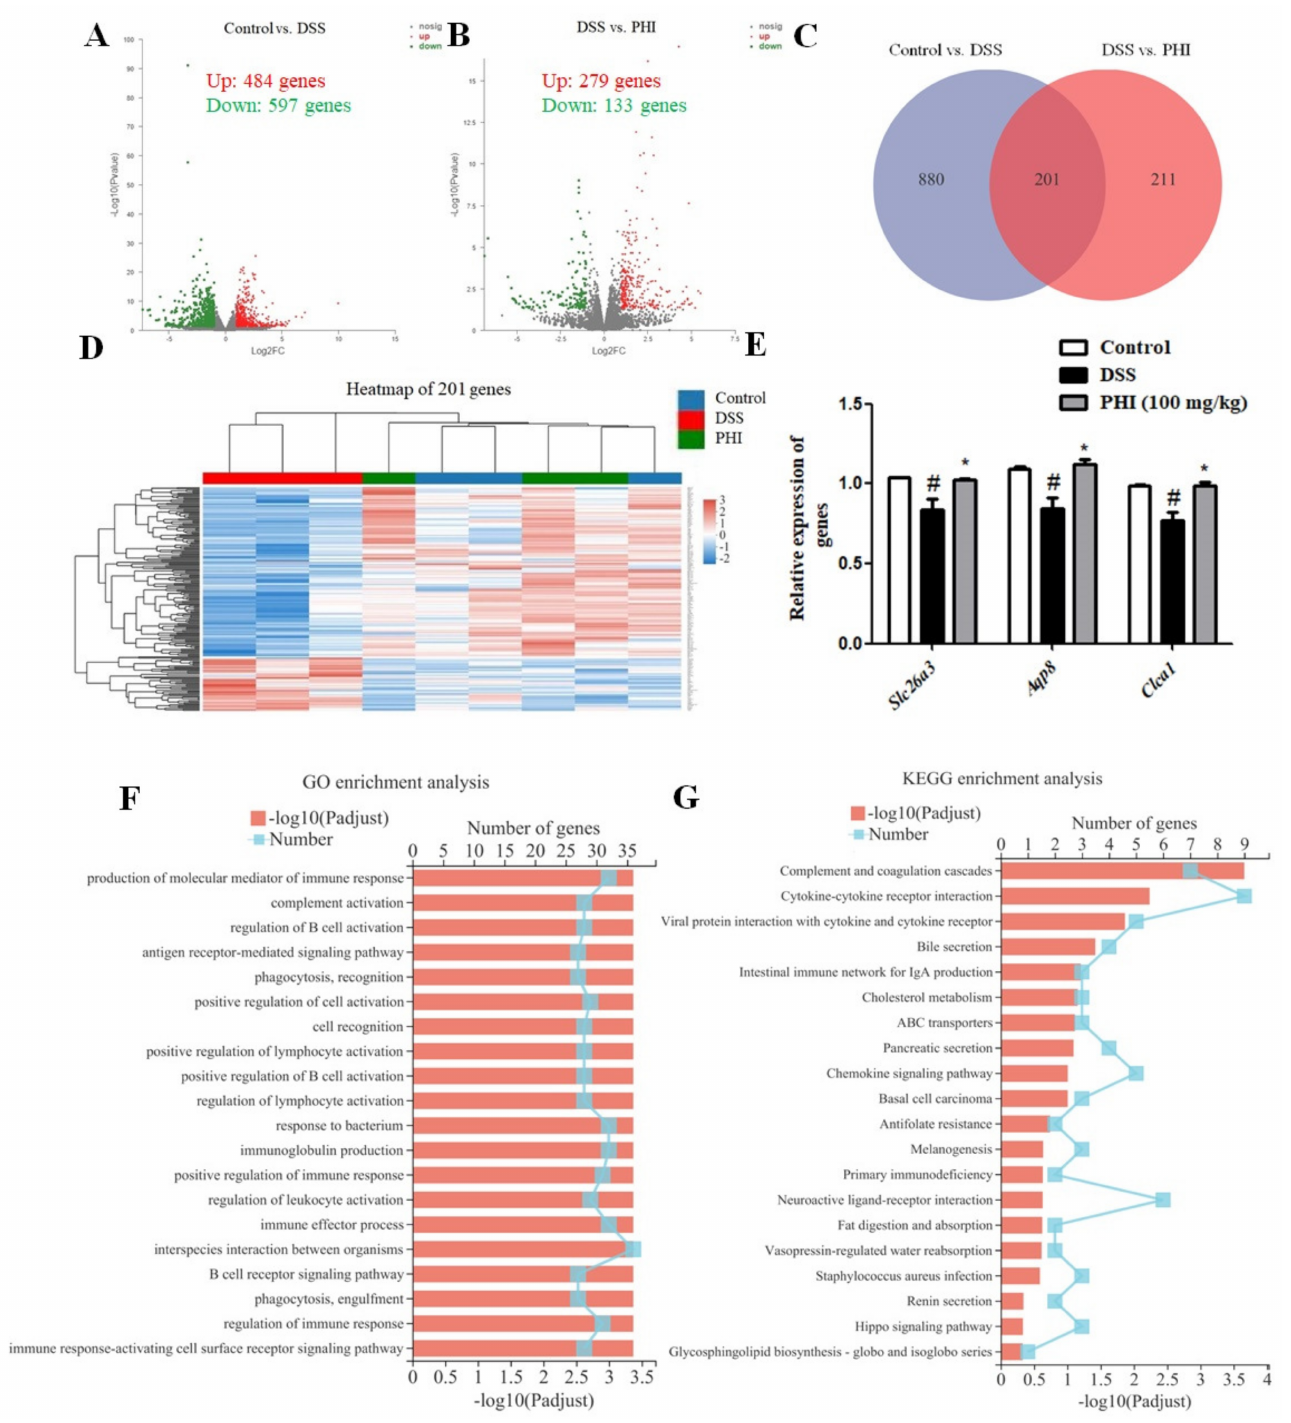
Figure 6. PHI (100 mg/kg) treatment altered transcriptional profiles of colitis mice. ( A ) Genes volcano map of control vs. DSS. ( B ) Genes volcano map of DSS vs. PHI. ( C ) Venn diagram of genes. ( D ) The clustering heat maps of 201 genes. ( E ) Genes were validated by using qRT-PCR. ( F ) Results of GO enrichment analysis. ( G ) Results of KEGG enrichment analysis. # p < 0.05 vs. control group. * p < 0.05 vs. DSS-induced group ( n = 3 mice per